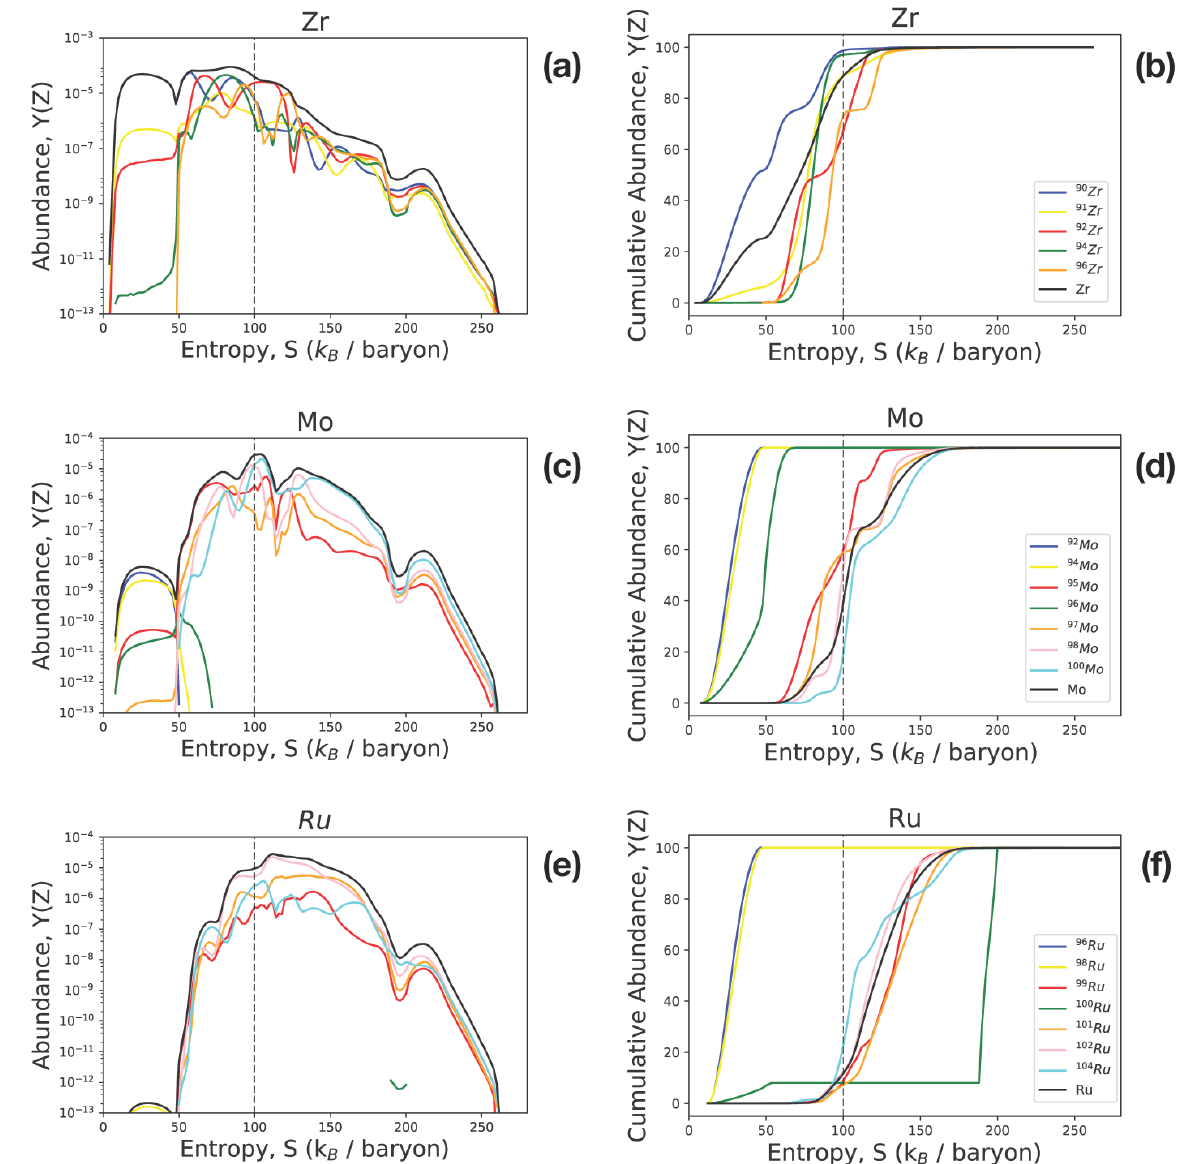
Figure 1. Isotope yields Y(Z) ( left panel ) and cumulative isotope yields ( right panel ) for Zr, Mo and Ru as a function of cumulative entropy (computed at Y e = 0.45). Hypothetical boundary between charged-particle and neutron-capture domains (occurring at S = 100 k B /baryon for Y e = 0.45) is indicated by vertical (dashed) line.